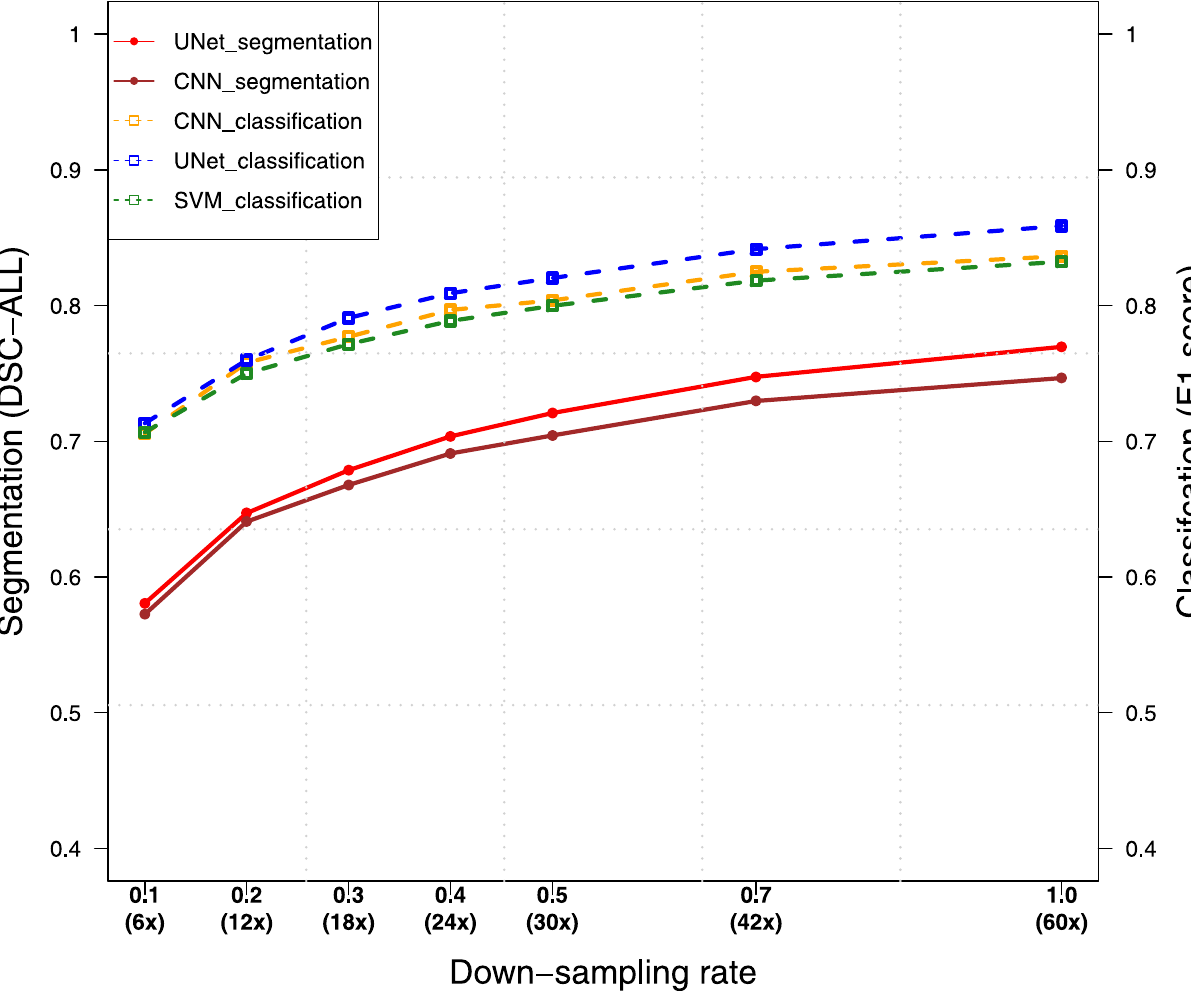
Fig 5. Performance of models using data of different read depths on the in-sample evaluation. Different read-depth data were generated through down-sampling NA12878 WGS data of 60x read depth. The dashed curves connect F1 scores of classification, while the line curves show DSC-ALL scores of